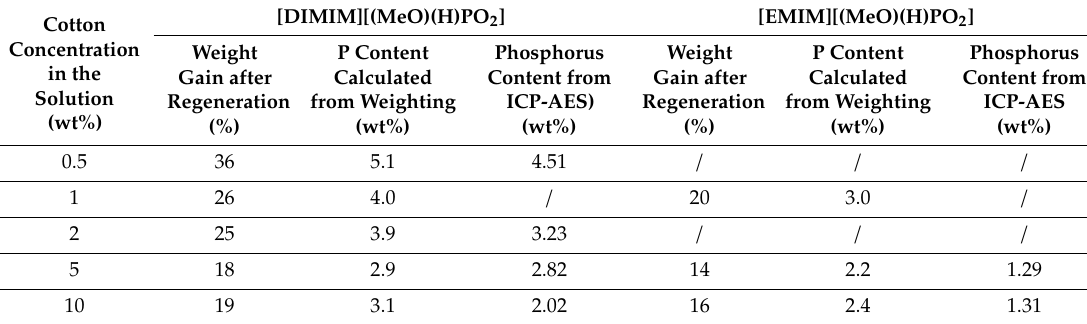
Table 1. The influence of fiber concentration on the weight gain and phosphorus content after the dissolution and regeneration of cotton cellulose in [DIMIM][(MeO)(H)PO 2 ] and [EMIM][(MeO)(H)PO 2 ]. Cotton